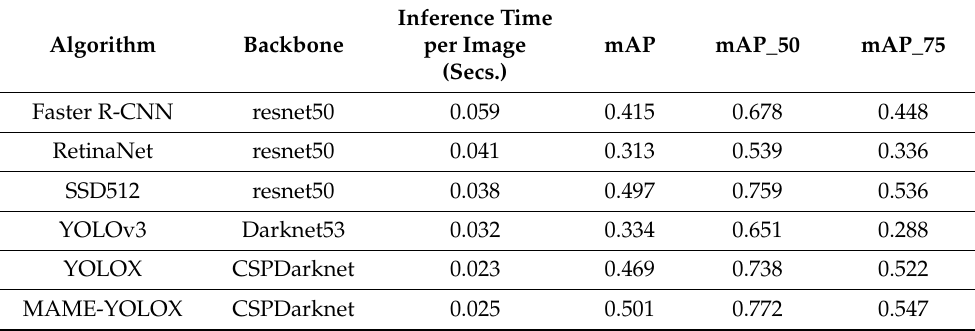
Table 6. Comparative experimental results of different algorithms on the DIOR